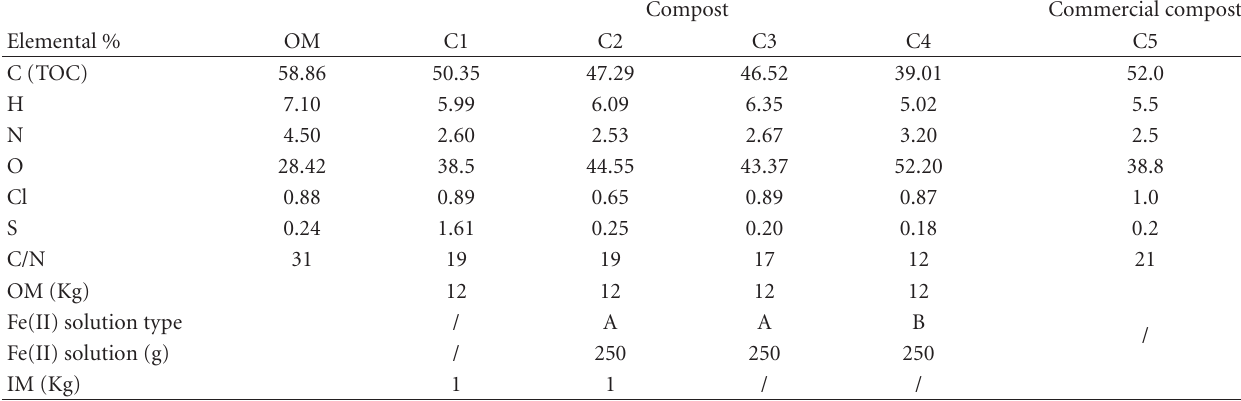
Table 1: Elemental percentages (organic mass) of the composts under di ff erent biodegradation conditions.